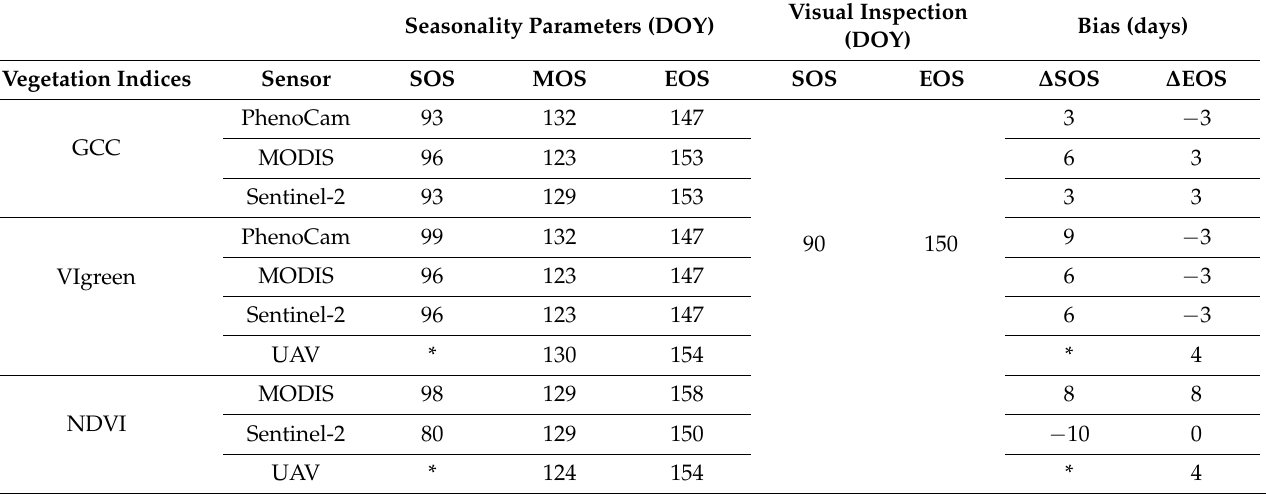
Table 7. Estimates of Start of Spring (SOS), Middle of Spring (MOS), and End of Spring (EOS), in day of year, computed using spline fitted time series of GCC, VIgreen, NDVI from all the platforms studied, and bias in number of days, with respect to visual inspection. Note ‘*’ represents no UAV flight data, thereby no